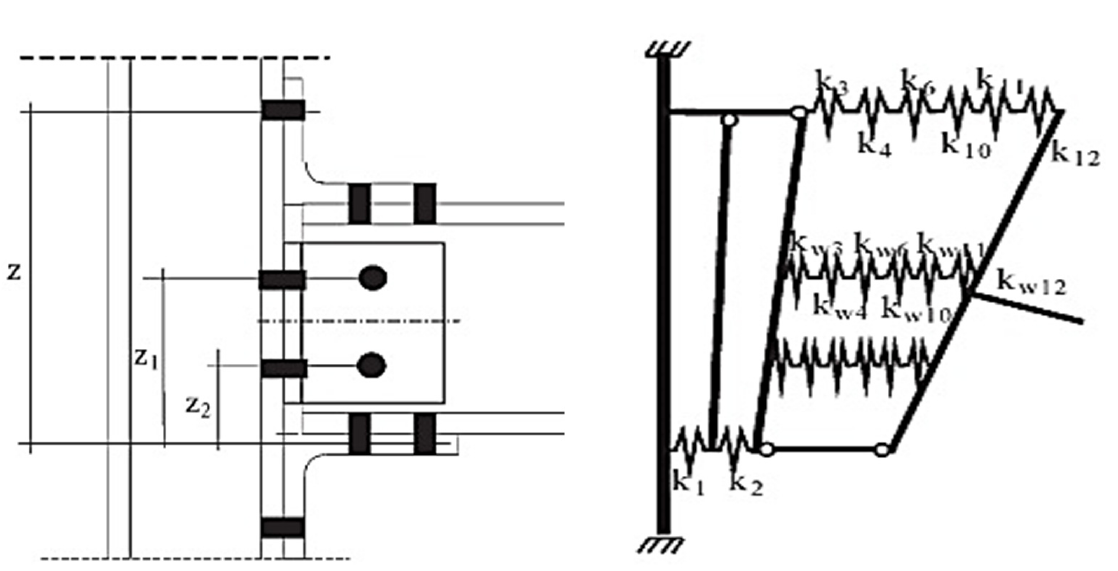
Figure 4 . Proposed extension of component-based model for TSACW . Figure 4. Proposed extension of component-based model for